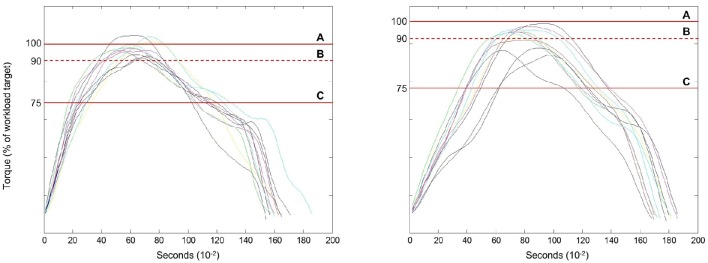
Workload adjustments based on the eccentric torque-time curves relative to the visual torque targets. Strengthening exercise involving the use of accommodating resistance requires an assessment of intra-session anaerobic fatigue data to make appropriate workload adjustments. The line graphs depict exemplar torque-time curves for eccentric knee extensor exercise. The torque targets include: Line A–the designated exercise workload, Line B–this dashed line is the lower-bound ±10% tolerance level for the acceptable attainment of peak torque during each repetition, and Line C–the indicator of peak torque levels that fall 25% below the designated exercise workload. The left panel captures a successful exercise set that would result in a 5% increase in the designated workload, whereas, the right panel reveals additional markers of anaerobic fatigue, but not fatigue levels that reach the criterion limit of 25%. The exercise performance shown on the right panel would result in the maintenance of the designated workload for the subsequent exercise session.